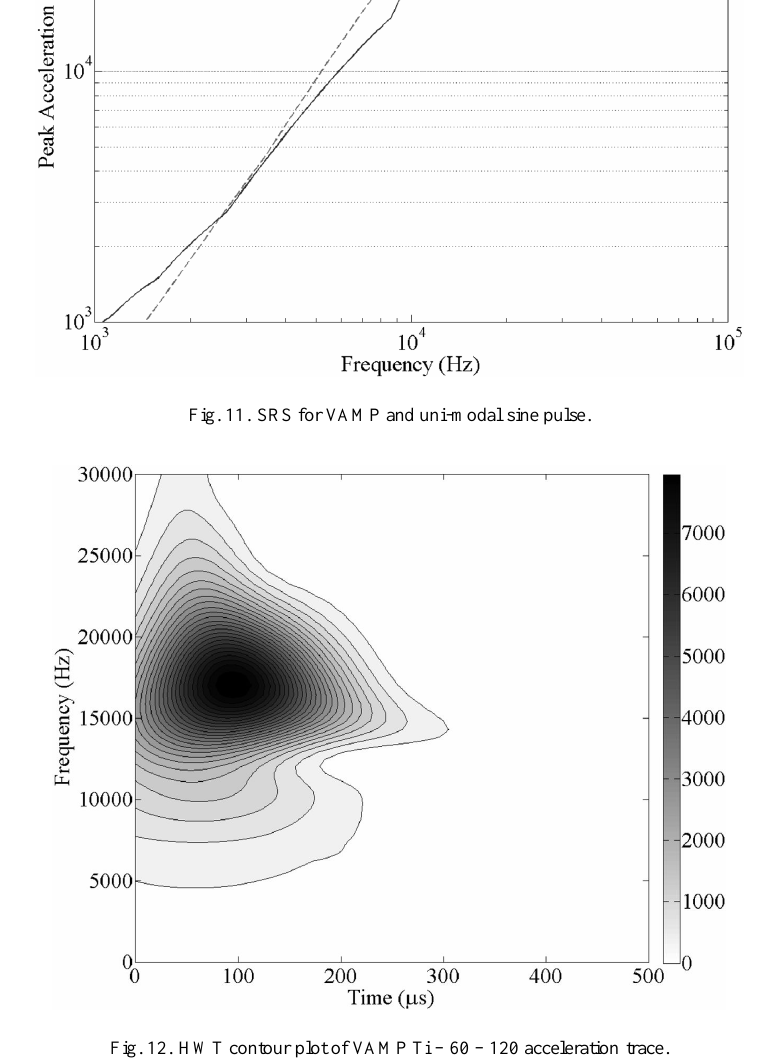
Fig. 12. HWT contour plot of VAMP Ti – 60 – 120 acceleration